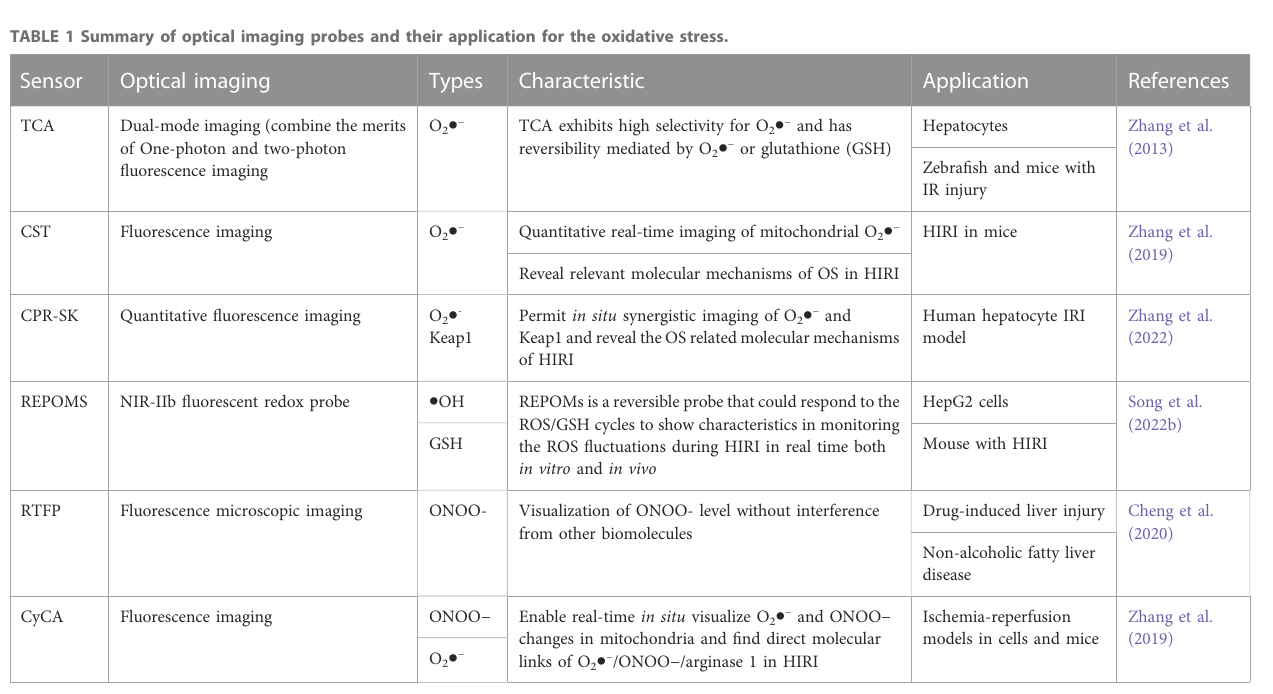
FIGURE 3 Schematic representation of the chemical structure of the Rhod-CN-B probe responding to ONOO − . Adapted with permission from (Peng et al., 2022). Copyright © 2022. American Chemical Society.